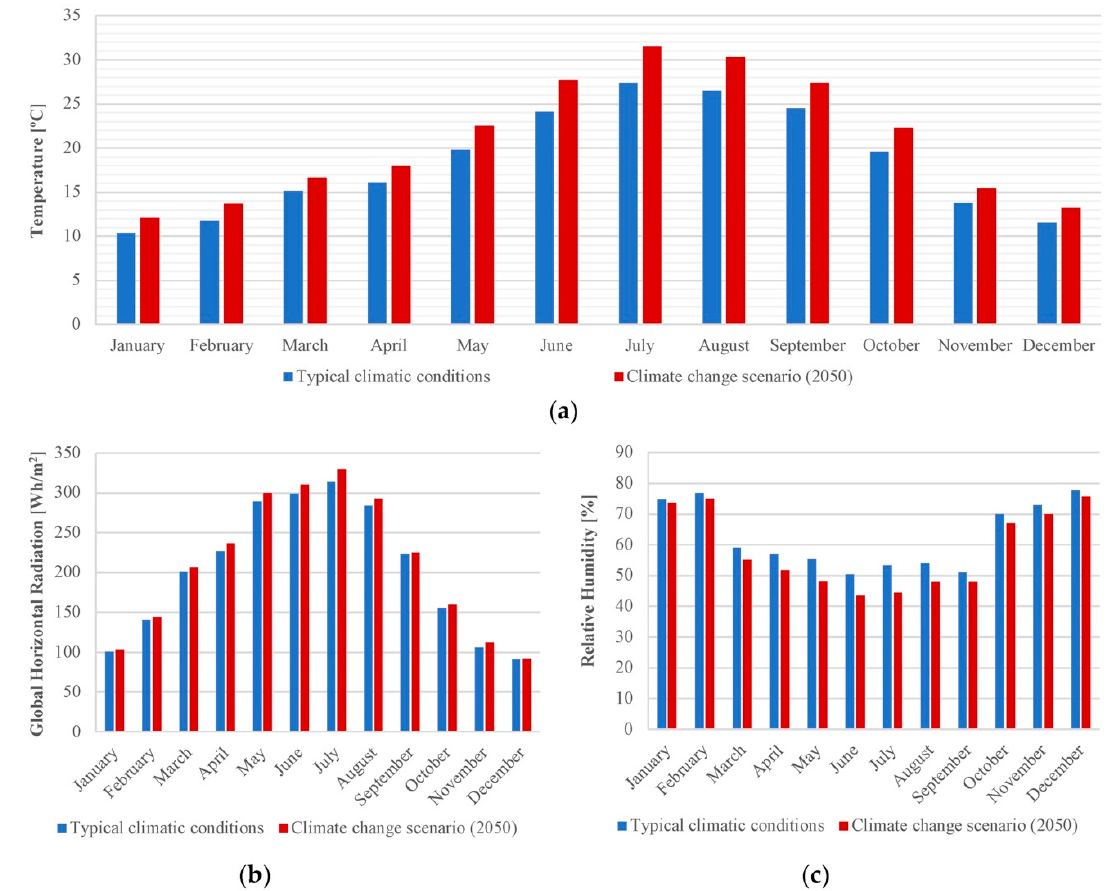
Figure 4. Monthly average of the hourly climate values for Seville, under typical climatic conditions and the 2050 climate scenario: ( a ) outdoor temperature; ( b ) global horizontal radiation; ( c ) relative